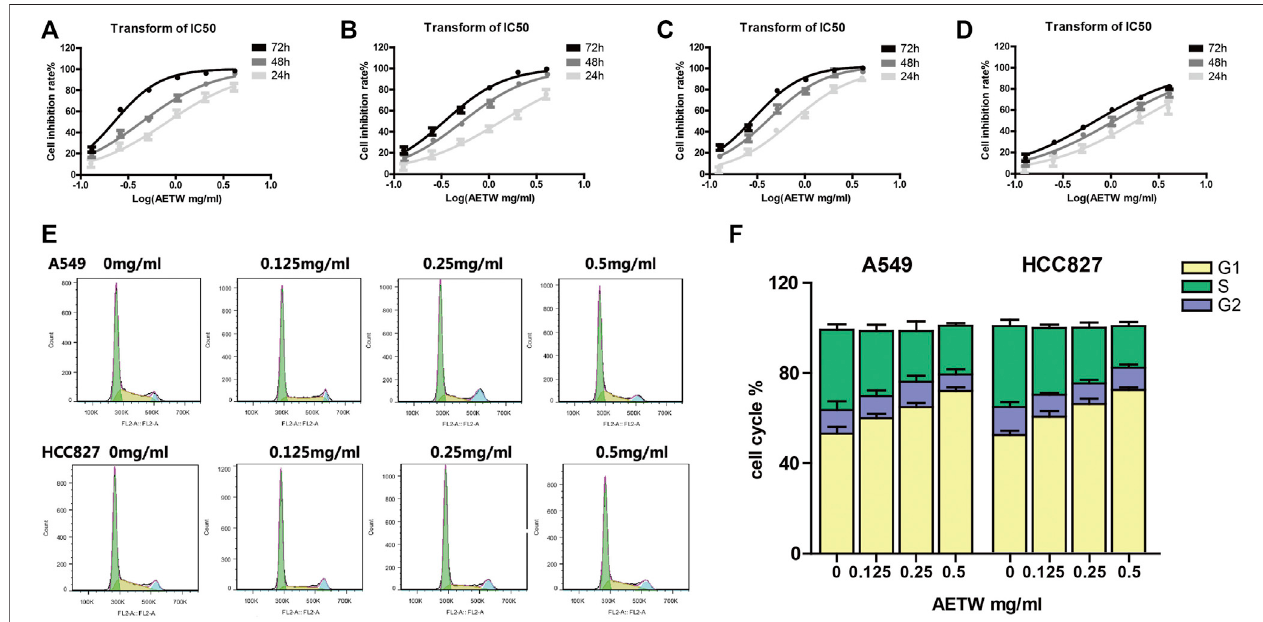
FIGURE4| In vitro cytotoxicityscreeningofLC (lung cancer) cellsfor AETW. The effects on A549 (A) and HCC827 (C) cellsweremore obvious thanon NCI-H358 (B) cellsandMRC-5 (D) cells.TheresultofLCcellcyclearrestwasinducedbyAETW.FlowcytometryanalysesillustratedthatcellsaccumulatedinSandG2phases (E) . Quantitative analyses of cell cycle distributions of A549 and HCC827 cells (F)